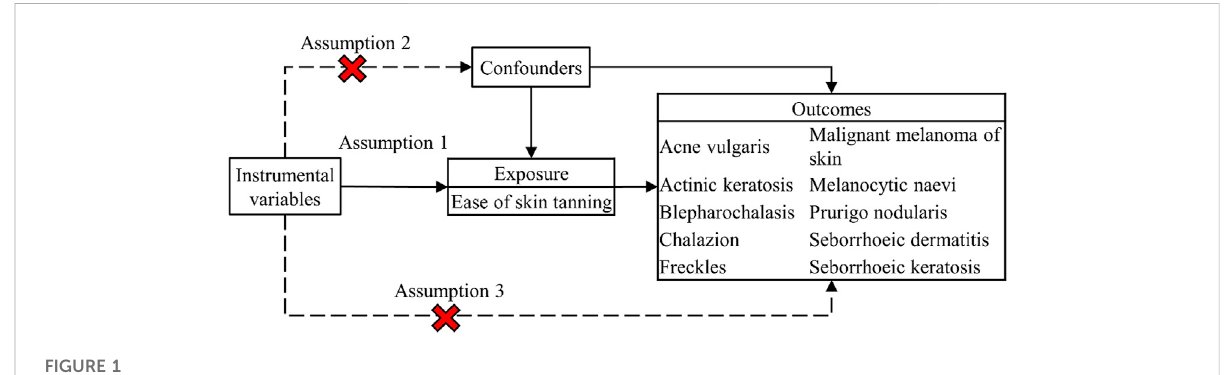
FIGURE 1 The fl ow chart of the MR